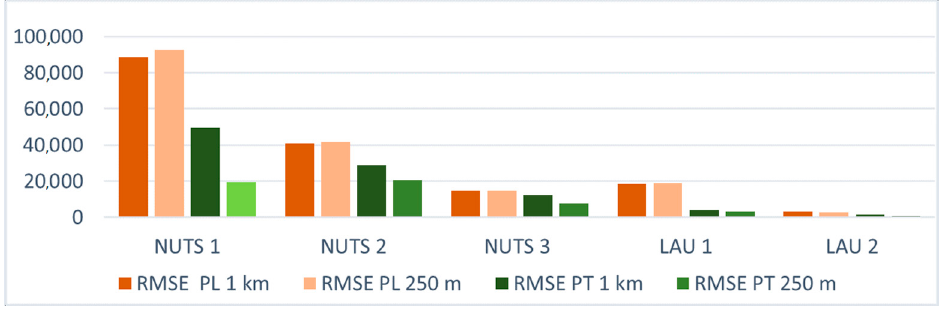
Remote Sens. 2019 , 11 , x FOR PEER REVIEW Figure 4. RMSE in Poland and Portugal. Figure 4. RMSE in Poland and Portugal.